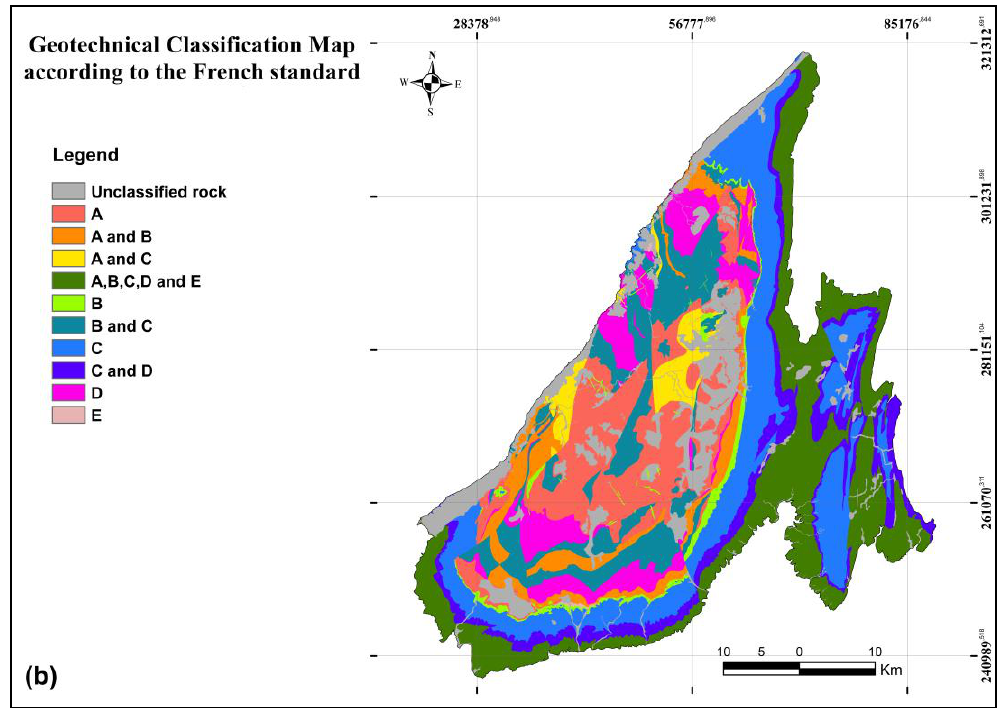
Figure 6. Geotechnical classification map: ( a ) According to the Moroccan standard. ( b ) According to the French standard.